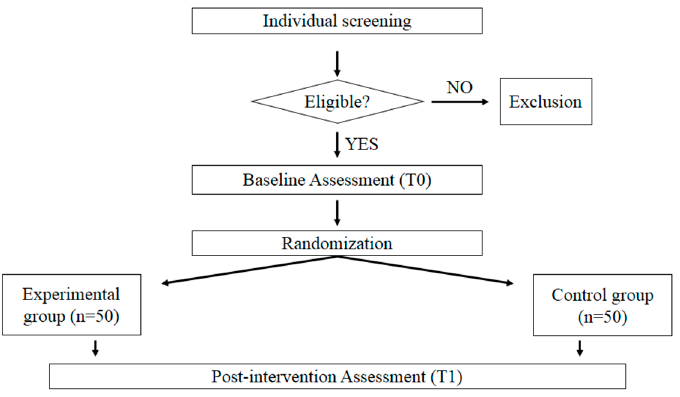
Figure 1. CONSORT flow chart for enrollment and randomization.